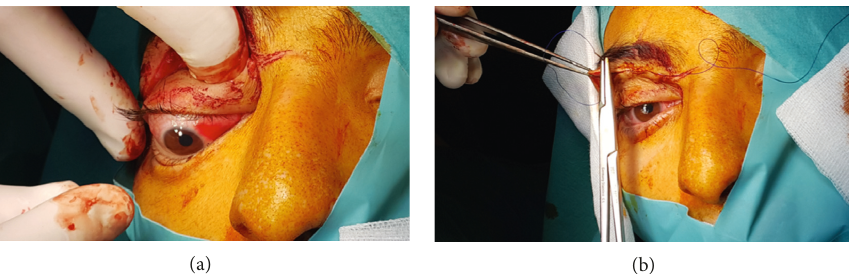
Figure 6: Intraoperative images. (a) Checking ocular bulb movements and relieving any movement constrictions. (b) End stage of the surgery: wound closure with intracutaneous sutures. We could observe the disappearance of the exophthalmus. The mydriasis appeared to increase, and pupil